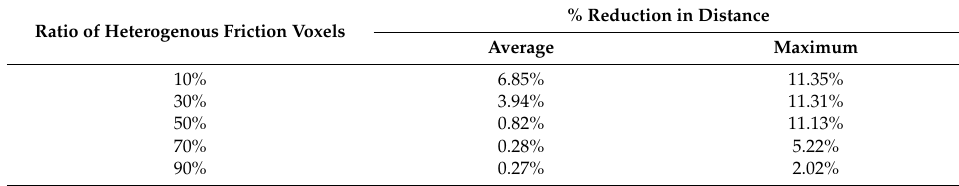
Table 2. Comparison between our method (modified) and the unmodified method with di ff erent friction